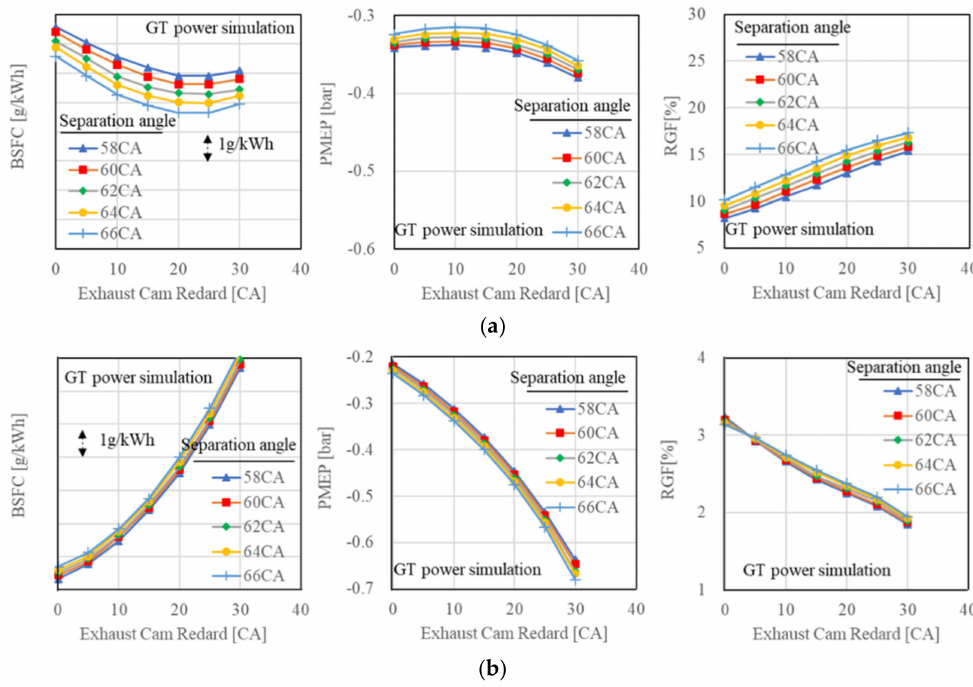
Figure 8. GT power simulation result: ( a ) BSFC, PMEP and RGF at 2000 rpm BMEP 8 bar condition; ( b ) BSFC, PMEP and RGF at 2500 rpm BMEP 14 bar